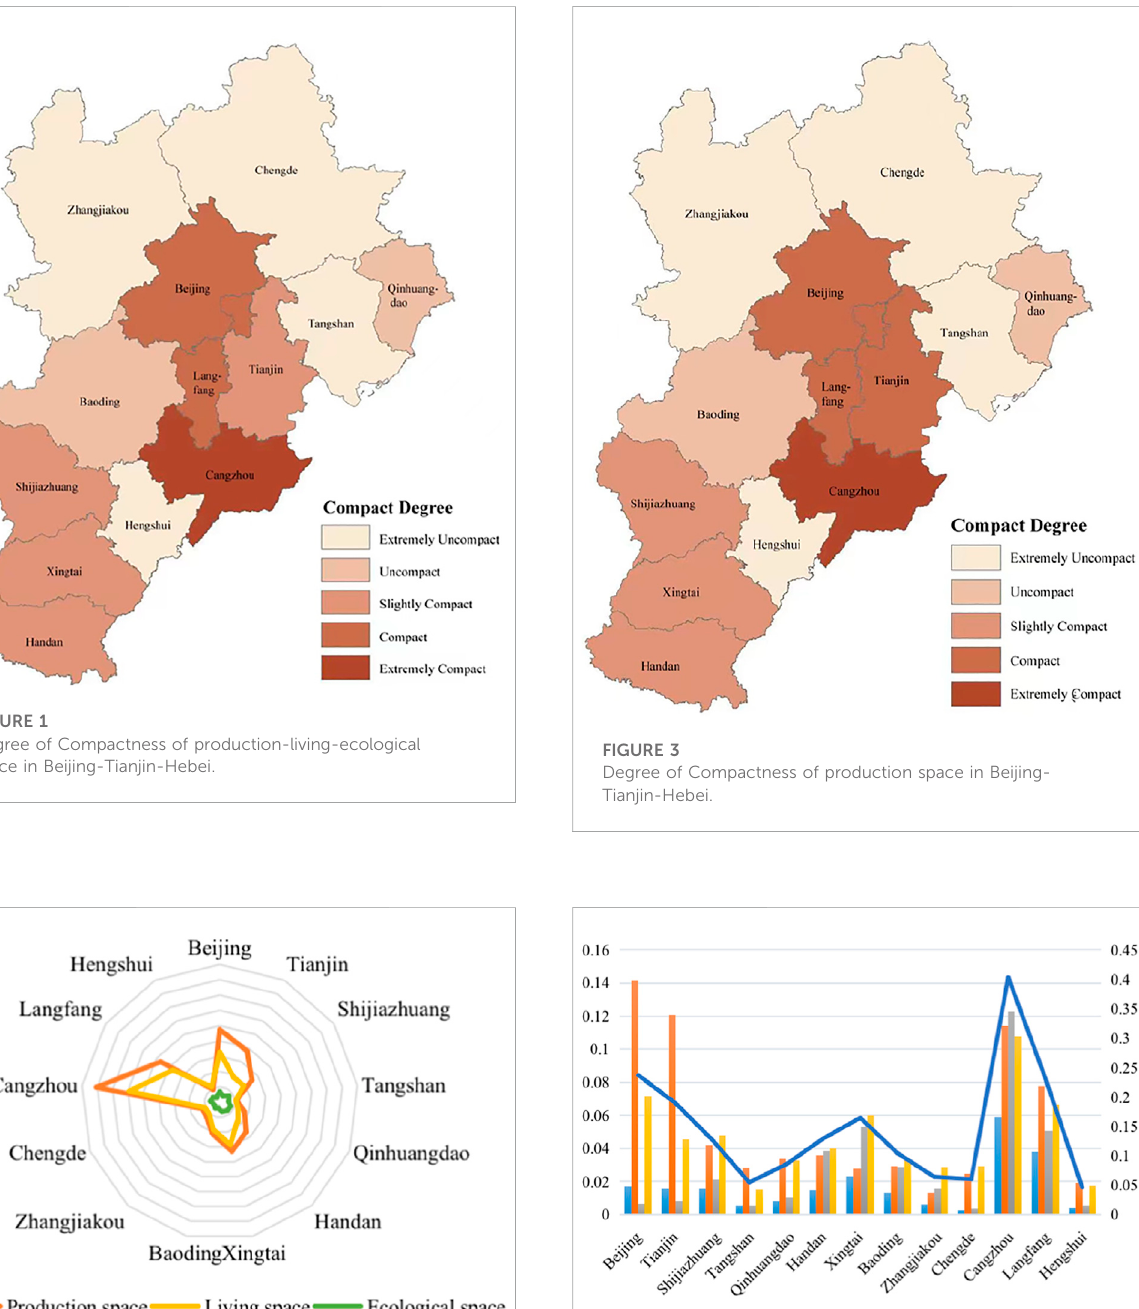
FIGURE 2 Compact development degree of production-living- ecological space in Beijing-Tianjin-Hebei.